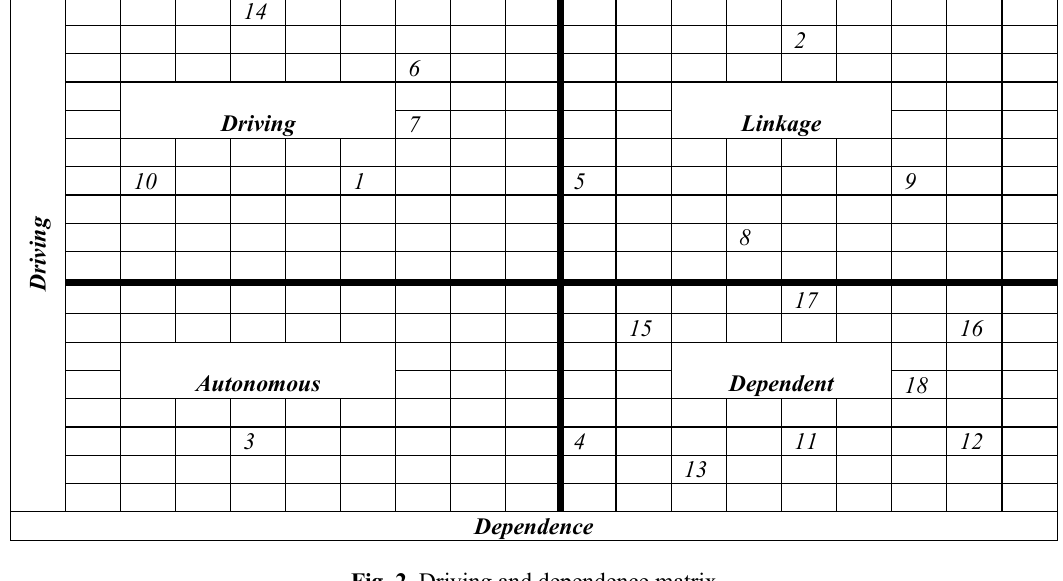
Fig. 2. Driving and dependence